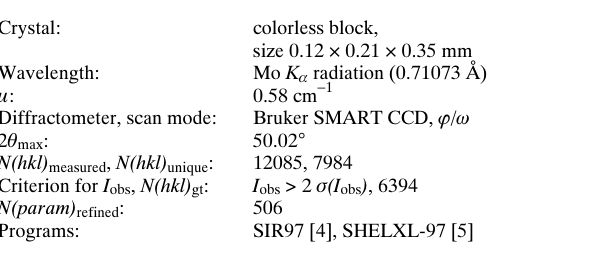
Table 1. Datacollection and